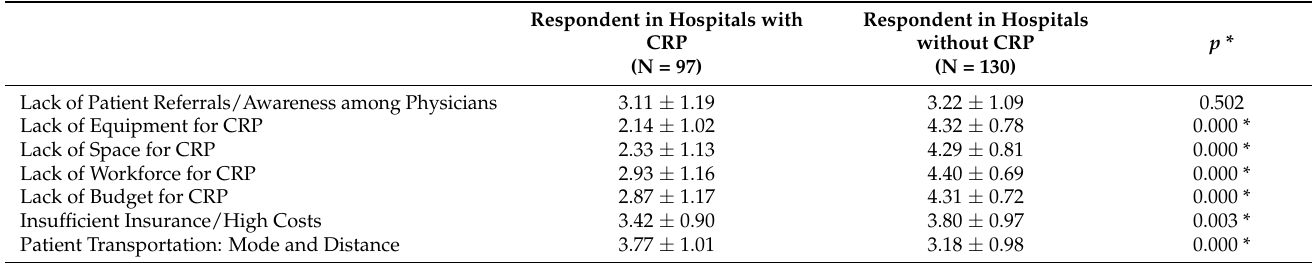
Table 3. Comparison of barrier factors between hospitals with and without cardiac rehabilitation programs (CRP).